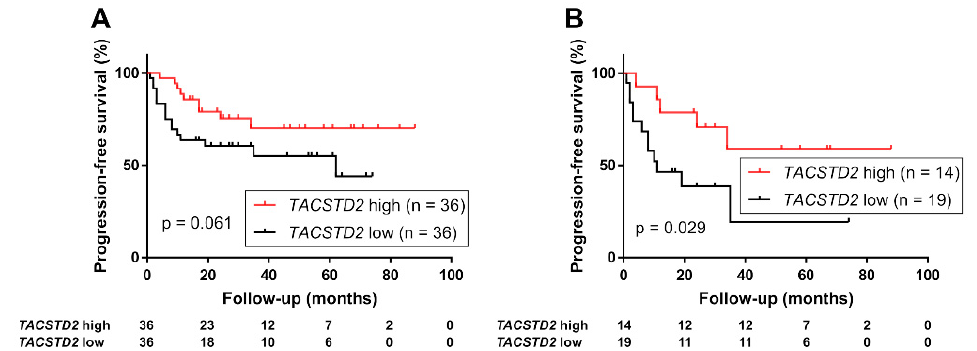
Figure 4. Progression-free survival in ( A ) 72 patients with upper tract urothelial carcinoma (UTUC) and ( B ) 33 patients with high-risk UTUC (with a pathologic stage of ≥ pT3 or positive lymphatic invasion or lymph node metastasis) stratified using expression of TACSTD2 gene (high vs. low).